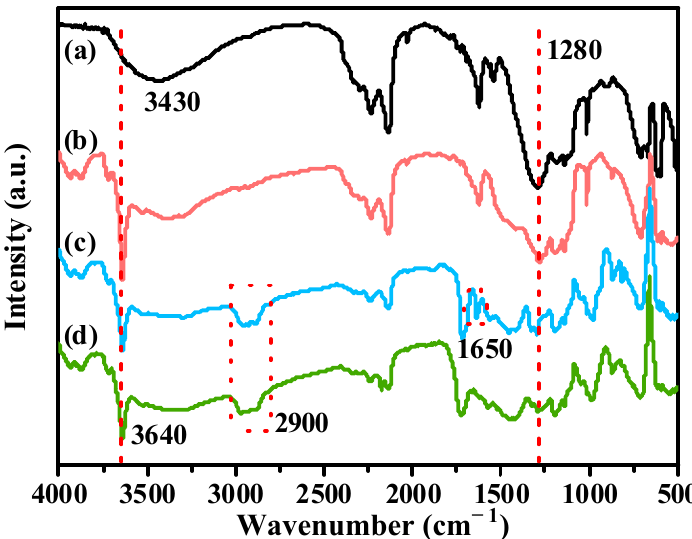
Figure 3. DRIFT spectra of ( a ) untreated CSWs, ( b ) CSW-OH, ( c ) CSW-OH-KH570, and ( d ) CSW-g-PMMA.